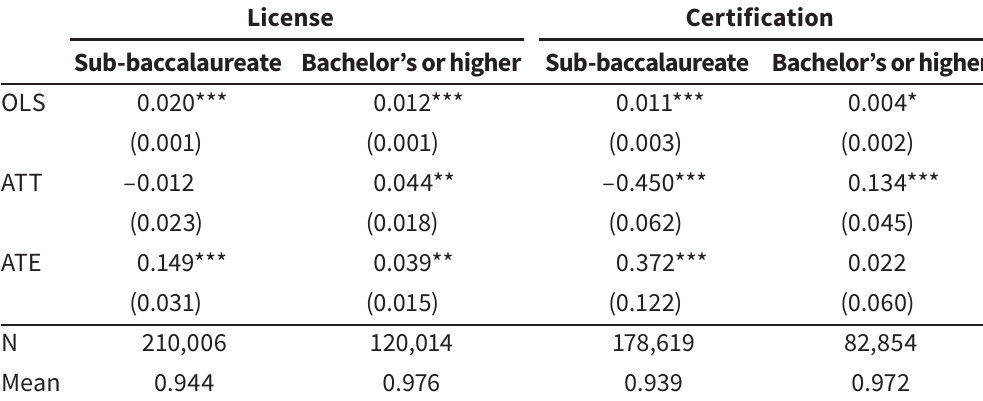
Effects of credential-holding on employment by level of education License